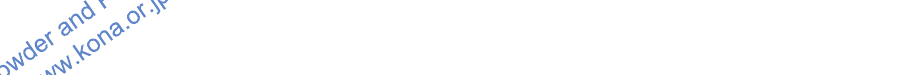
TABLE 4 - SIZE EFFECTS- BLENDS OF MATERIALS 1, 2, 3